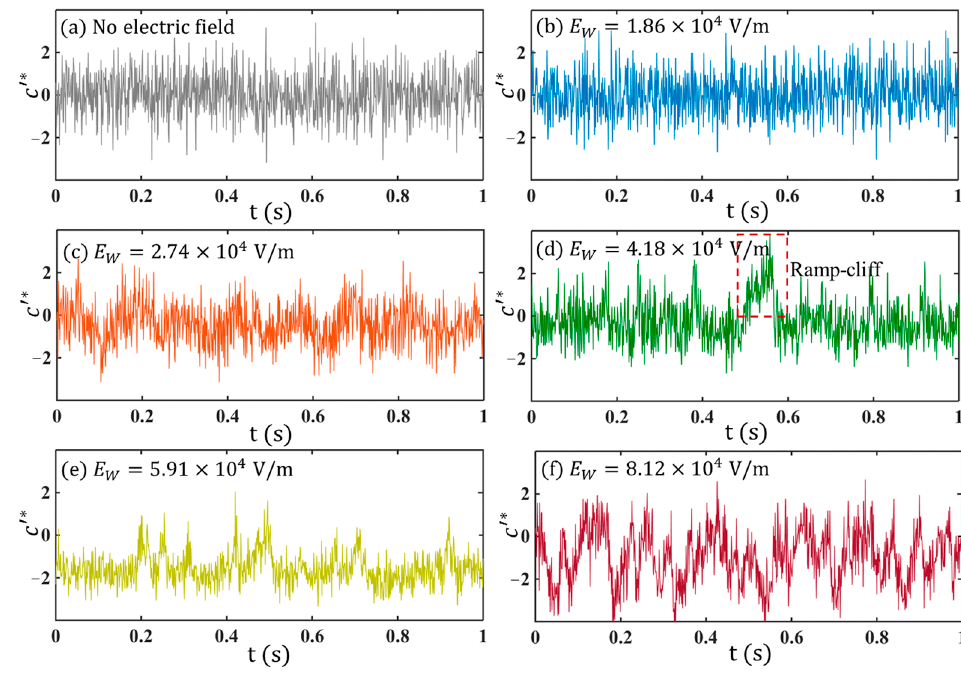
Figure 7. Time series of 𝑐 (cid:4593)∗ under different 𝐸 (cid:3024) at 𝑄 = 3 µL/min and 𝑓 (cid:3033) = 130 kHz. ( a ) without force, ( b ) 𝐸 (cid:3024) = 1.86 × 10 (cid:2872) V/m, ( c ) 𝐸 (cid:3024) = 2.74 × 10 (cid:2872) V/m, ( d ) 𝐸 (cid:3024) = 4.18 × 10 (cid:2872) V/m, ( e ) 𝐸 (cid:3024) = 5.91 × 10 (cid:2872) V/m, and ( f ) 𝐸 (cid:3024) = 8.12 × 10 (cid:2872) V/m.